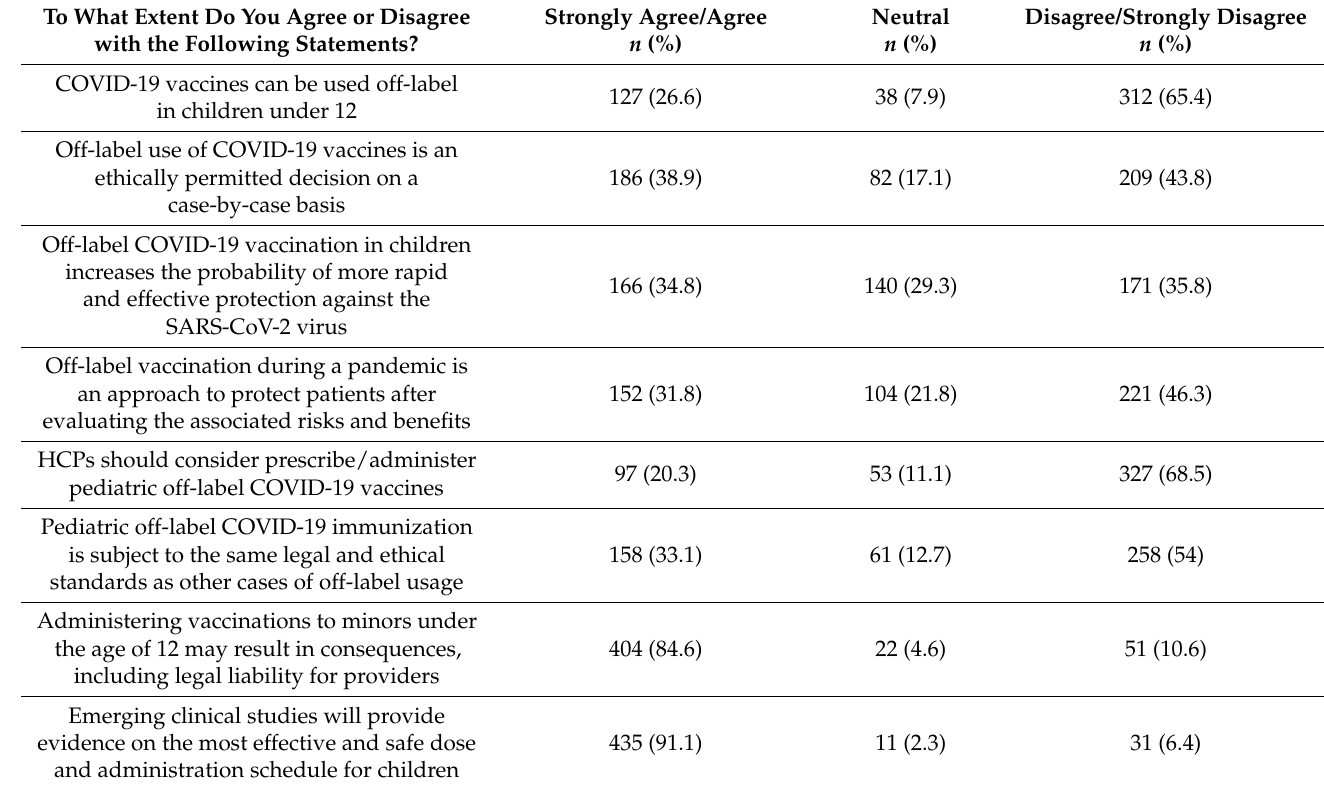
Table 4. Respondents’ perceptive towards off-label COVID-19 vaccination in